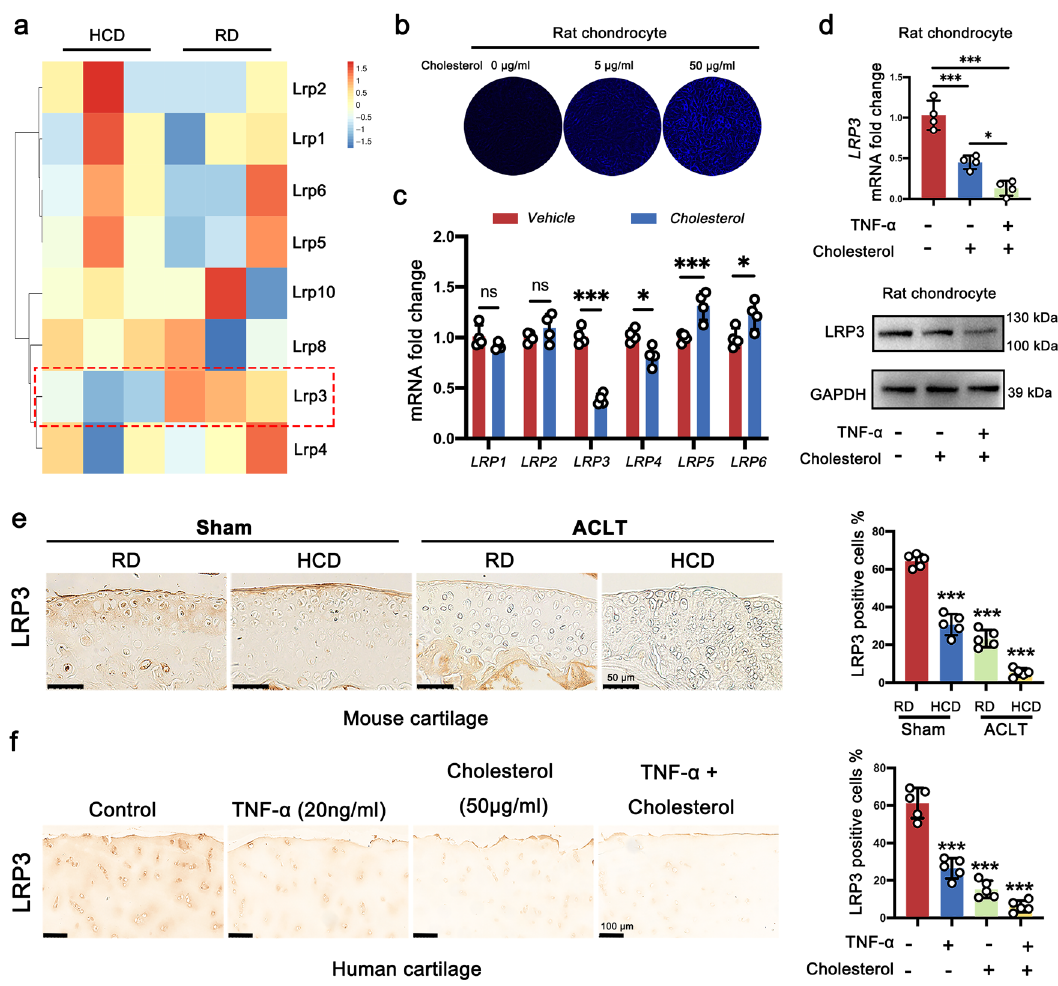
Fig. 2 | High cholesterol downregulates the expression of LRP3 in cartilage. a Heatmap of mRNA-seq analysis in cartilage tissue of HCD and RD mice. b Filipin stainingtodetectcholesterolinratchondrocytestreatedwithcholesterol(0,5,and 50 μ g/ml). c Quanti fi cation of mRNA levels for LRP1 , LRP2 , LRP3 , LRP4 , LRP5 , and LRP6 in rat chondrocytes treated with cholesterol (50 μ g/ml) ( n =4, two-tailed Student ’ s t -test). d Quanti fi cation of LRP3 mRNA ( n =4, one-way ANOVA) and proteinlevelsinratchondrocytestreatedwithcholesterol(50 μ g/ml)and/orTNF- α (20ng/ml). e IHCstainingforLRP3inHCDmiceandRDmicesubjectedtoShamor